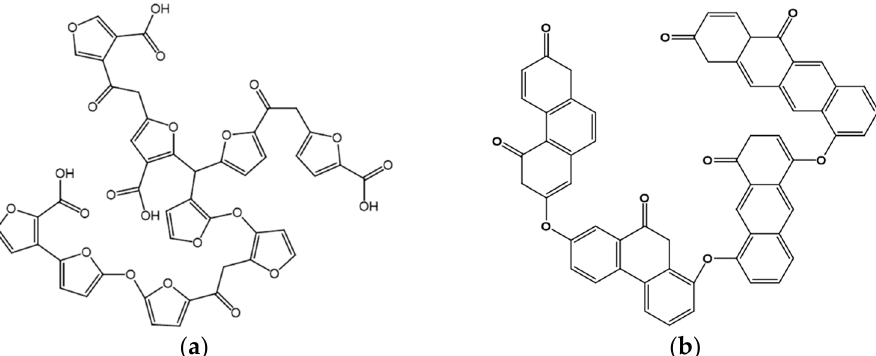
Figure 2. Proposed structures for ( a ) as-synthesized HTC material and ( b ) mesoporous carbon from phenolic resin carbonized at 500 °C based on [25] and [26], respectively.